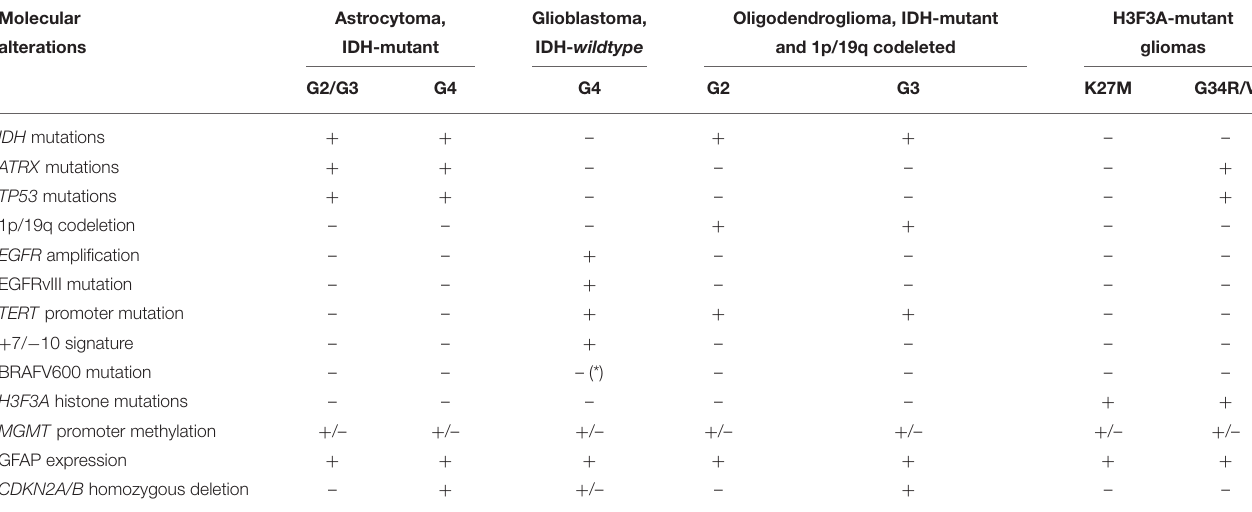
TABLE 1 | Molecular alterations linked to the diagnosis of glioma